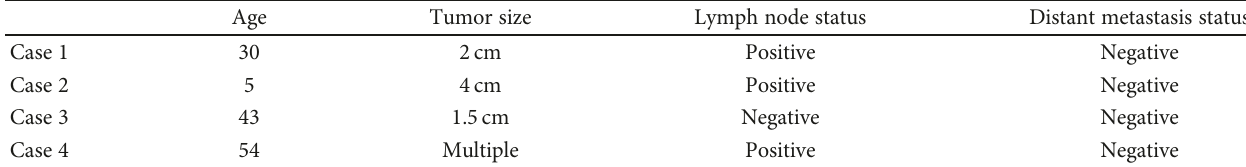
Table 1: Clinicopathological features of 4 thyroid papillary carcinoma cases.